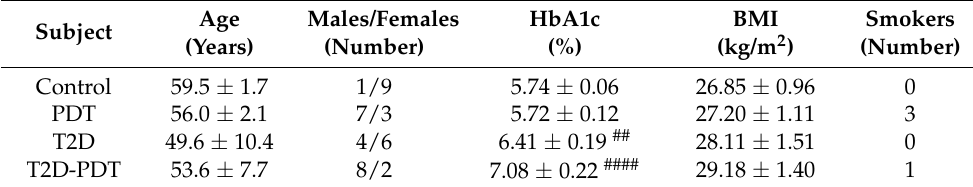
Table 1. Subject characterization according to age, gender, and clinical